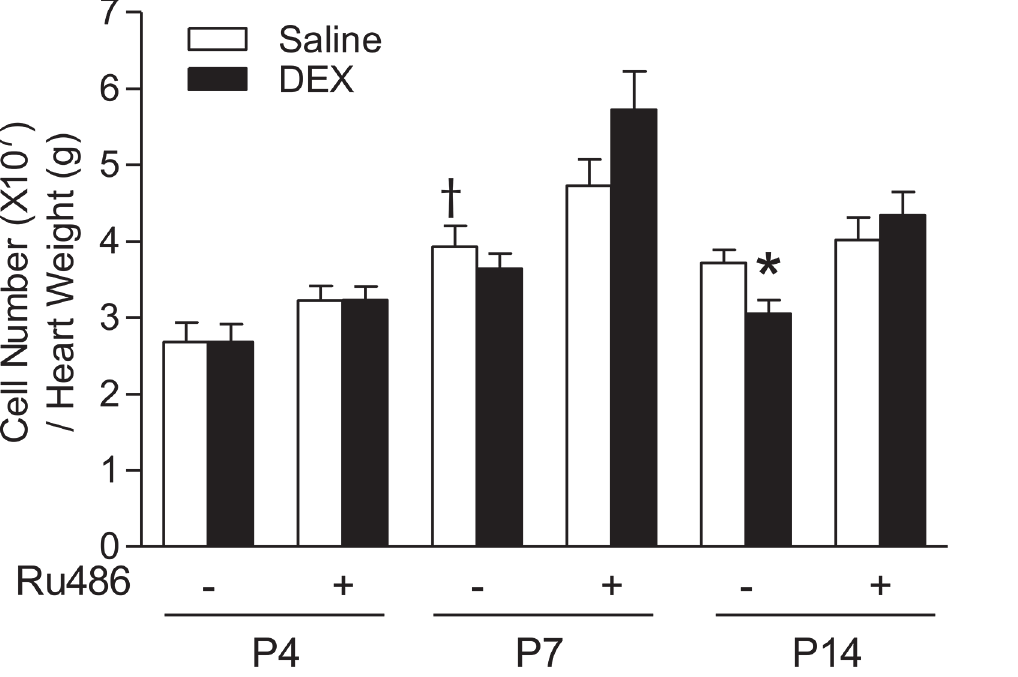
Fig 4. Effect of dexamethasone (DEX) on cardiomyocyte number in neonatal rats. Newborn rats were treated with tapered dose of DEX in the absence or presence of Ru486 during the first three days of postnatal life. Ru486 was administered 30 minutes prior to the DEX treatment. Cardiomyocytes isolated from day 4 (P4), day 7 (P7) and day 14 (P14) neonatal hearts were counted and normalized to per gram of heart weight. Data are mean ± SEM, n = 6 – 20. * p < 0.05, DEX vs . Saline; † p < 0.05, P7 vs .